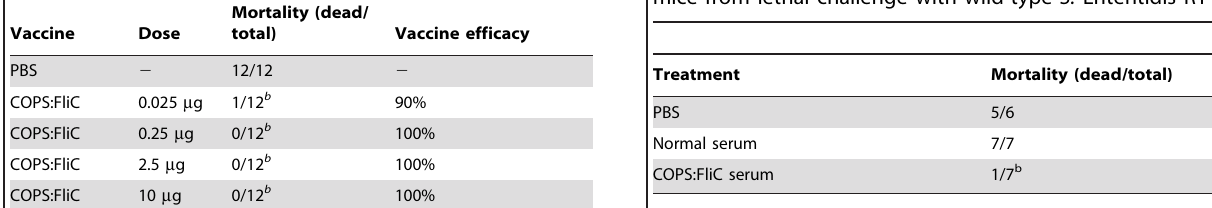
Table 1. Efficacy of different doses of Salmonella Enteritidis COPS:FliC conjugate in protecting mice from lethal challenge with wild-type S. Enteritidis R11 a . Table 2. Efficacy of passive immunization into naı¨ve mice with sera from mice immunized with COPS:FliC in protecting mice from lethal challenge with wild-type S. Enteritidis R11 a